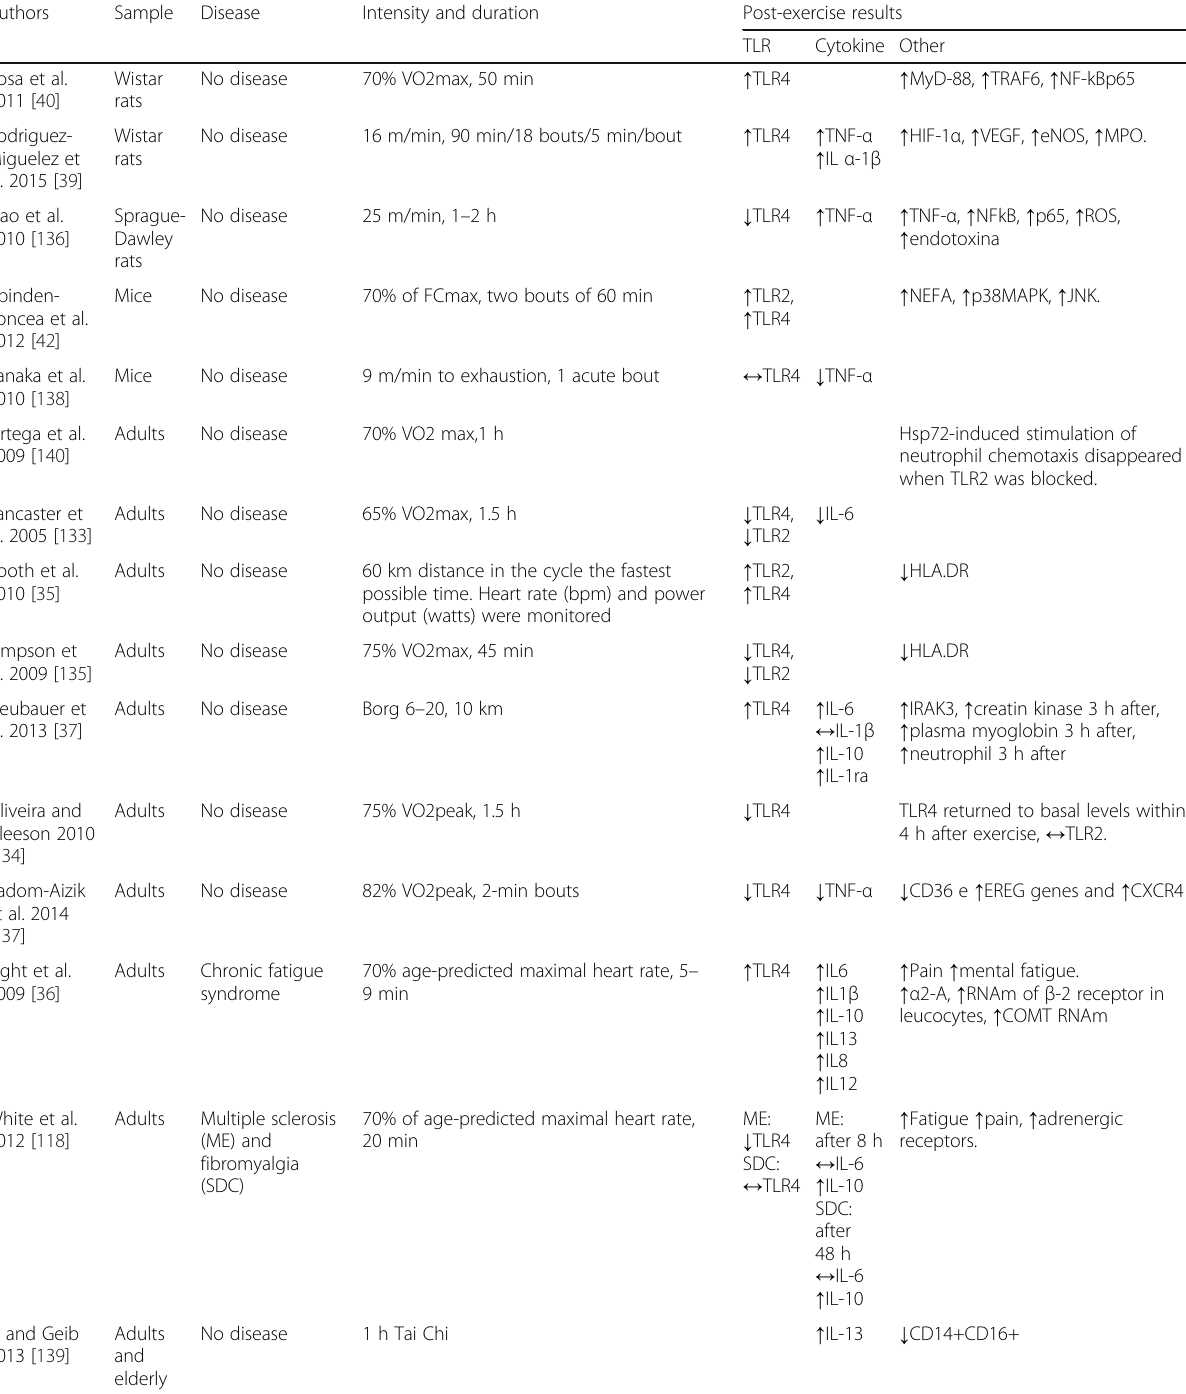
Table 7 Modulation of TLR2 and TLR4 after acute aerobic exercise